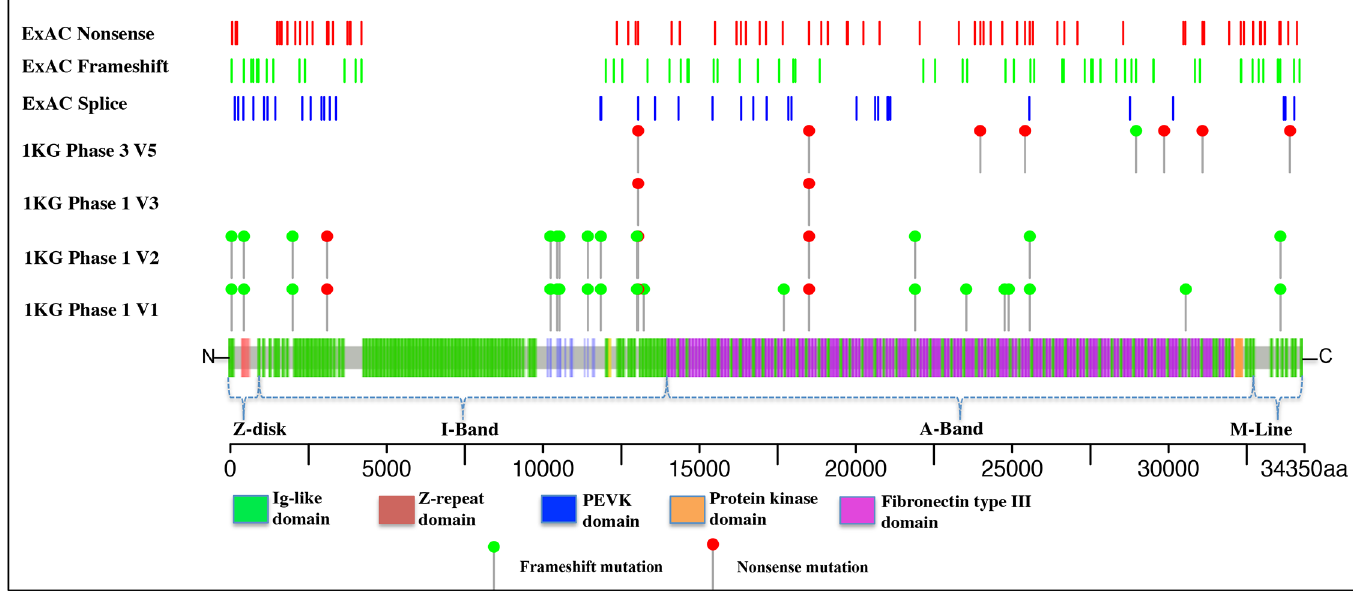
Fig 3. Spatial distribution of titin frameshift, nonsense and splice-site mutations in reference populations. Titin is linearly depicted with its 152 Ig-like domains in green and 132 fibronectin type III domains in purple. TTNtv are shown as lollipops and bars. Depicted are nonsense (red) and frameshift (green) mutations in various phases of the 1000 Genomes project. Dark grey bars represent the complete map of various TTN mutations from ExAC. Variants are shown relative to the titin Uniprot Sequence identifier Q8WZ42. The dashed lines below the protein schematic indicate the location of variants within the sarcomere. Abbreviations: 1KG – 1000 Genomes project; ESP – Exome Sequencing project; ExAC — Exome Aggregation Consortium; V – version.